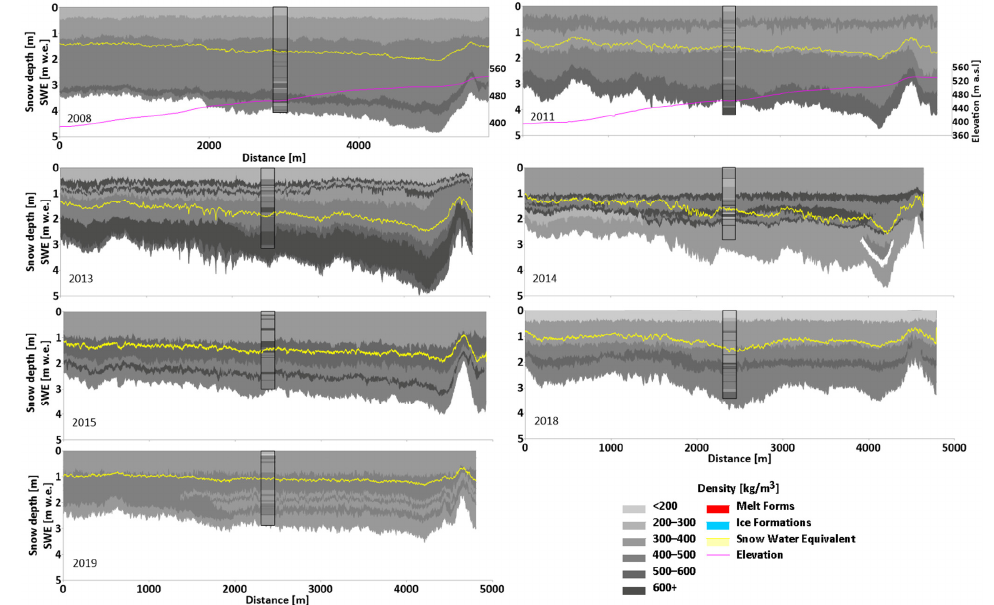
Figure 8. Snow density and SWE. Pink lines show the elevation along with the GPR profile in 2008 (different profile course than in other seasons) and 2011 (representative for seasons 2011–2019). Vertical rectangles in the middle of the GPR profiles denote HS and density in the snow pits (H9). The white spaces represent undefined density. See the location of the GPR profiles on Figure 1.